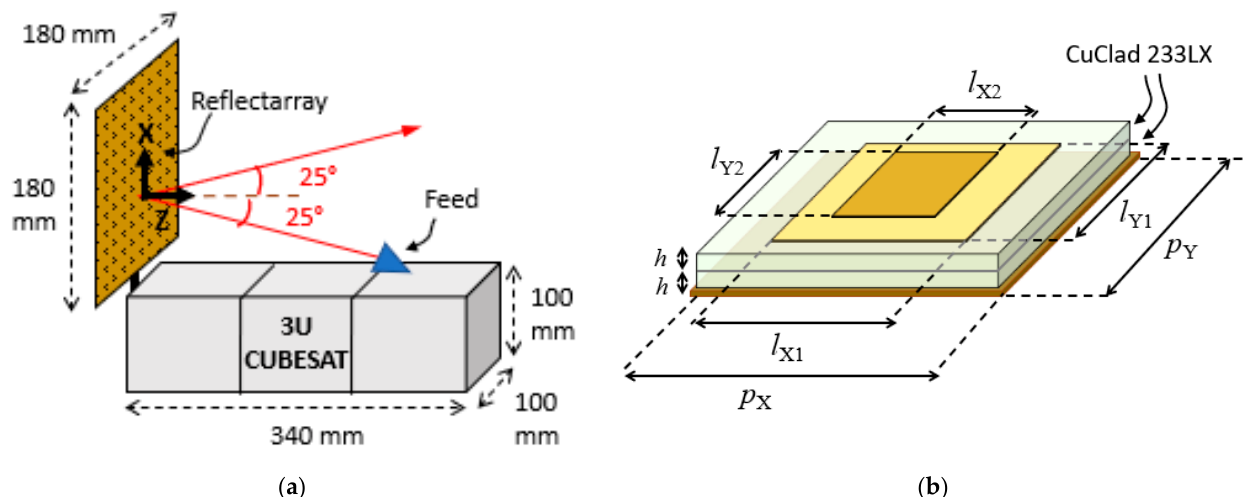
Figure 2. ( a ) Representation of the reflectarray antenna mounted on the CubeSat. ( b ) Dual-layer reflectarray cell formed by two stacked rectangular patches. All units are in mm.